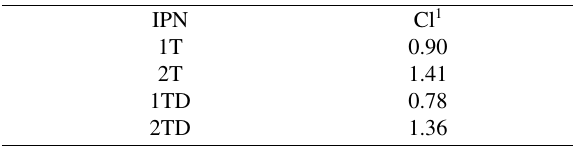
Table 2. Determined amount of chlorine present in the synthesized resins.